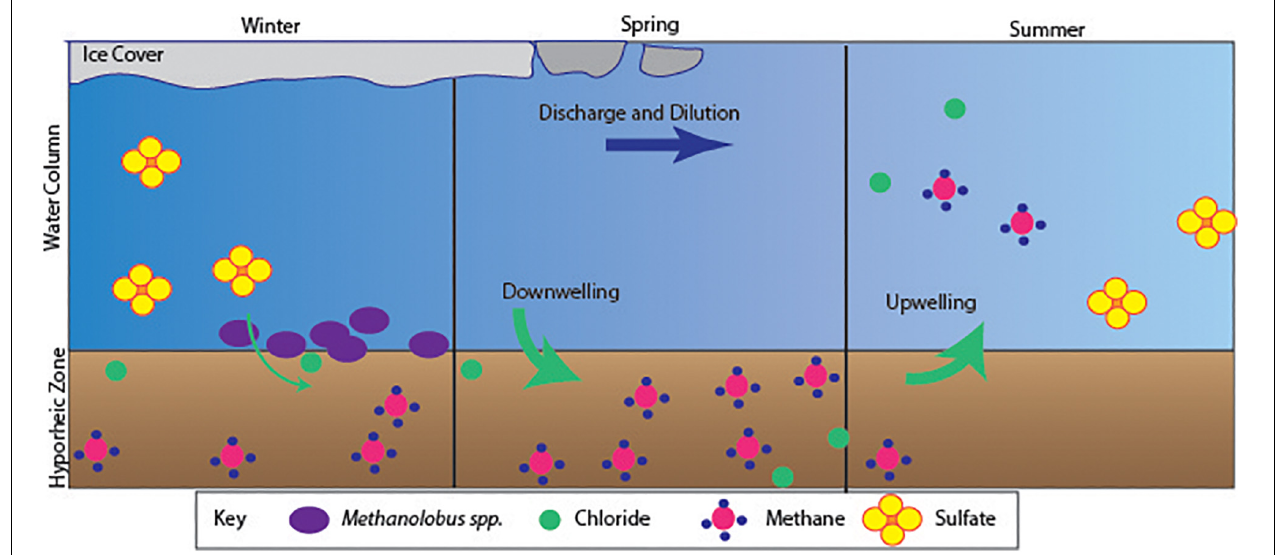
FIGURE 5 | Conceptual model of biogeochemical processes within the ER study